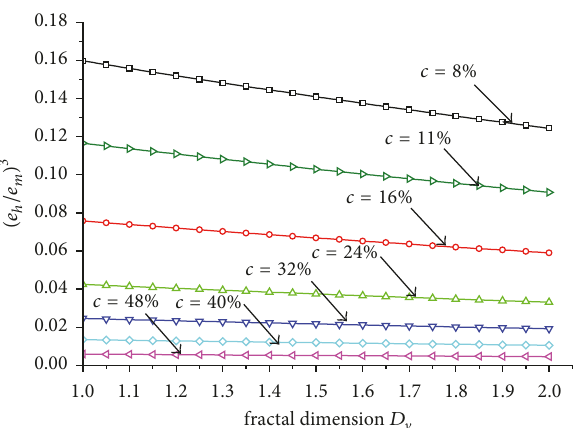
Figure 14: Variation of (𝑒 ℎ /𝑒 𝑚 ) 3 with 𝐷 V at various values of 𝑐 predicted by (15).